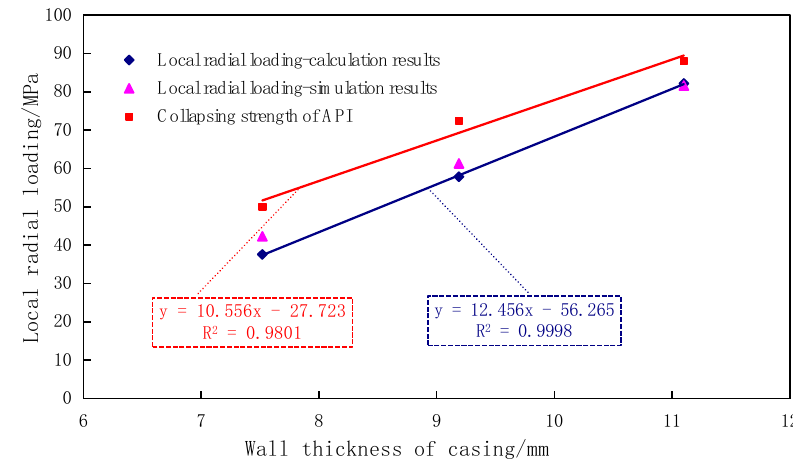
Figure 14. Calculation results of deformation on different wall thicknesses of 4½ ″ N 80 -type casing.